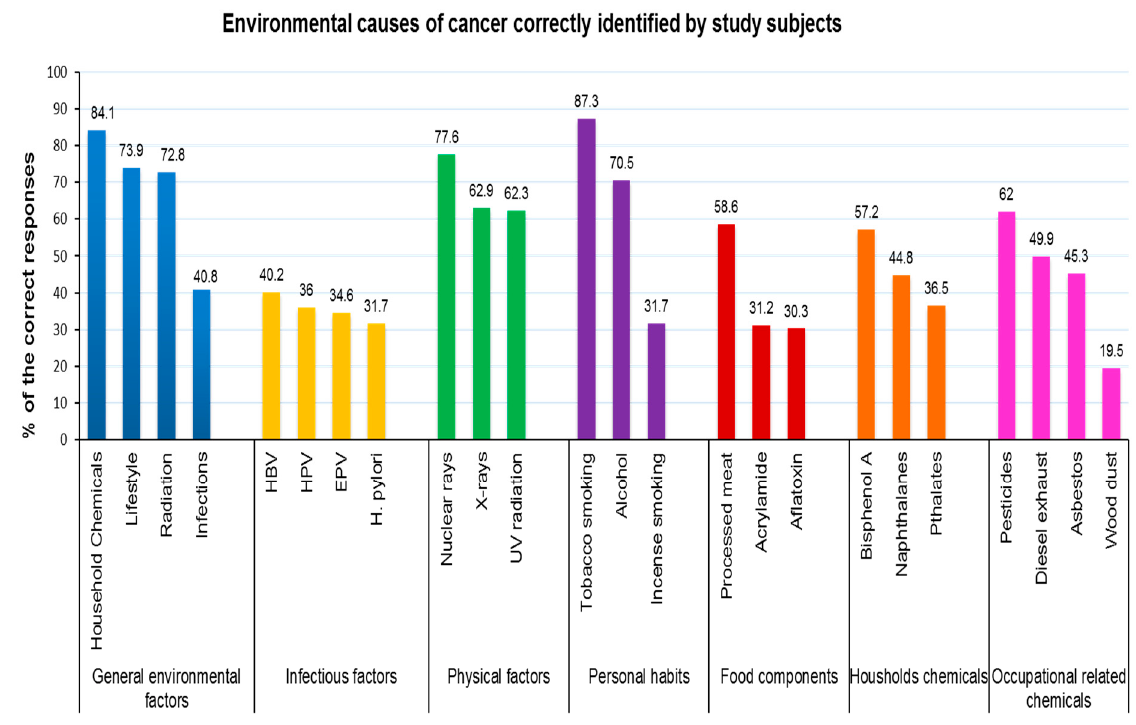
Figure 3. Environmental causes of cancer correctly identified by the study subjects. HBV: Hepatitis B virus; HPV: Human Papilloma virus; EPV: Epstein–Barr virus; H. pylori: Helicobacter pylori.